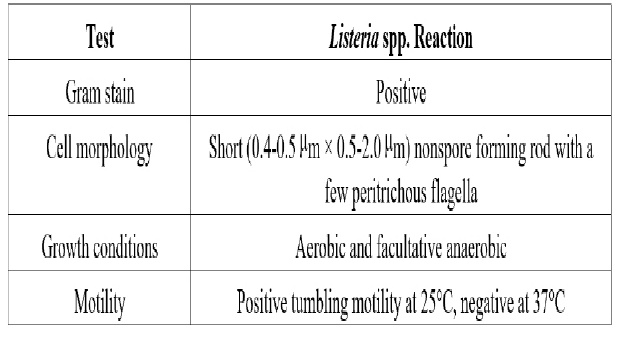
7. Gram Staining: